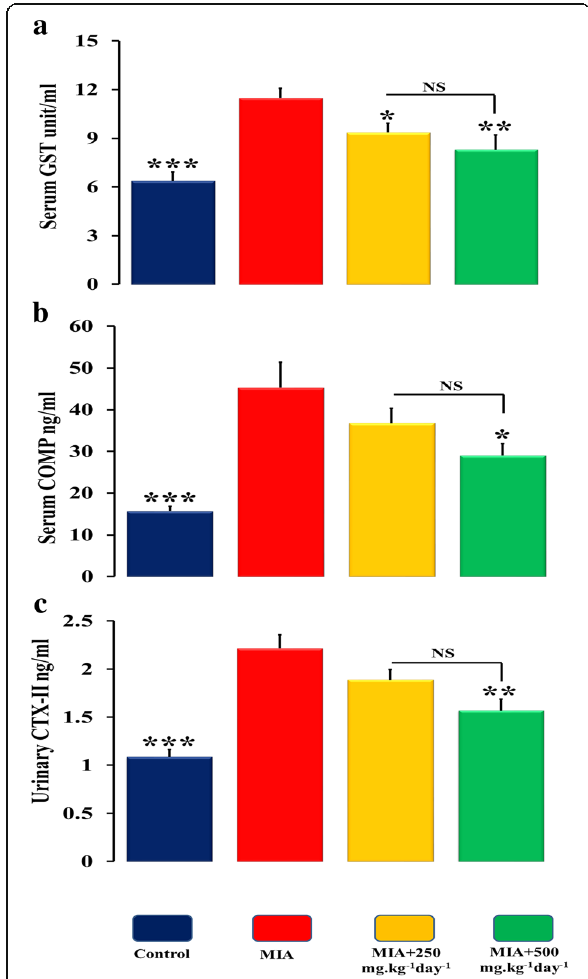
Fig. 8 Effect of SOE on serum and urinary osteoarthritic markers. a Serum GST level measurements b serum COMP measurements and c urinary CTX-II levels. All values are expressed as Mean±S.E.M. ( n =6/ group); * P <0.05, ** P <0.01, *** P <0.001 compared to the MIA